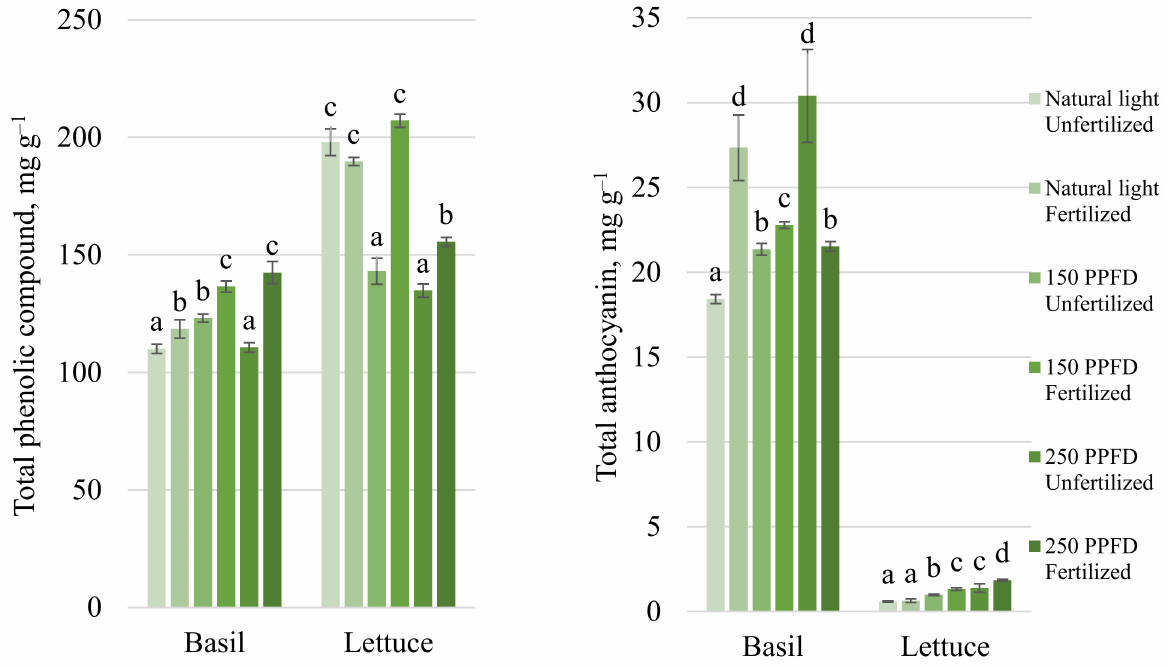
Figure 4. Effect of light intensity and fertilization on total phenolic compounds and anthocyanins in lettuce and basil. Natural light corresponds to 4.6 mol m − 2 d − 1 ; 150 µ mol m − 2 s − 1 corresponds to 8.6 mol m − 2 d − 1 ; 250 µ mol m − 2 s − 1 corresponds to 14.4 mol m − 2 d − 1 . Values are mean ± SE of 10 replicates, and values with different letters differed significantly according to Tukey multiple comparison test ( p ≤